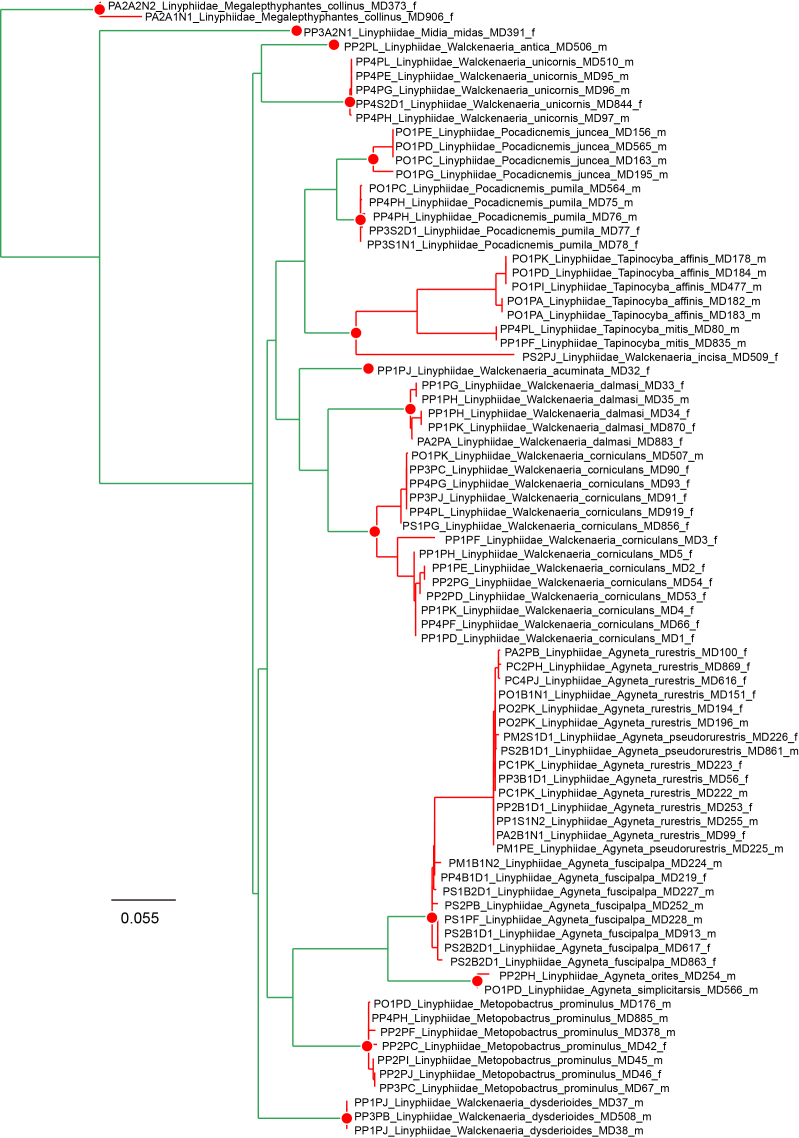
Maximum likelihood tree of the Linyphiidae DNA barcode sequences analysed, using a codon partition model with IQ-tree. Red coloured clusters correspond to candidate species as delimited using the mPTP algorithm (see text for details).